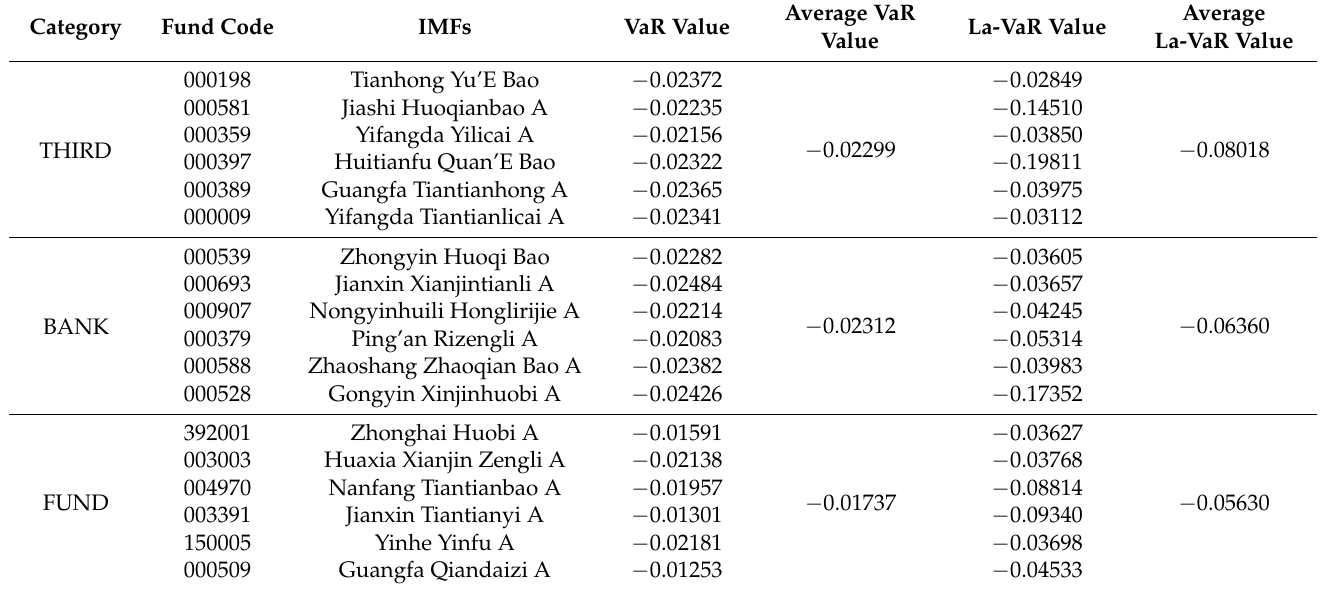
Table 5. The VaR and La-VaR values of